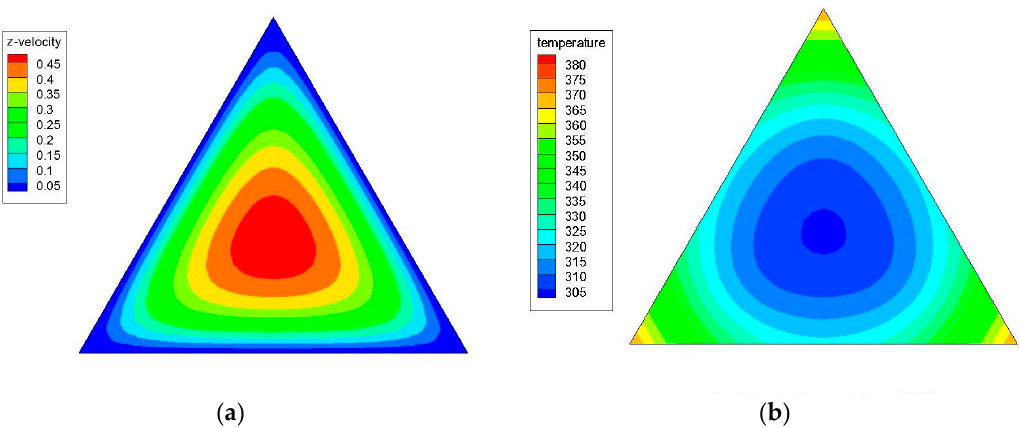
Figure 7. ( a ) Axial velocity and ( b ) temperature contours in a triangular cross-sectional duct with a hydraulic diameter ( D h ) of 3.5 mm at z / D h = 200 and Re = 1100 for CuO/water nanofluid with 0.5% nanoparticle volume concentration.